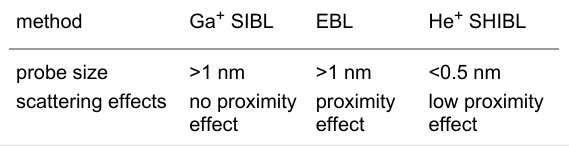
Table 2: Comparison of beam diameters and scattering effects for dif- ferent charged particle lithography methods. method Ga + SIBL EBL He + SHIBL probe